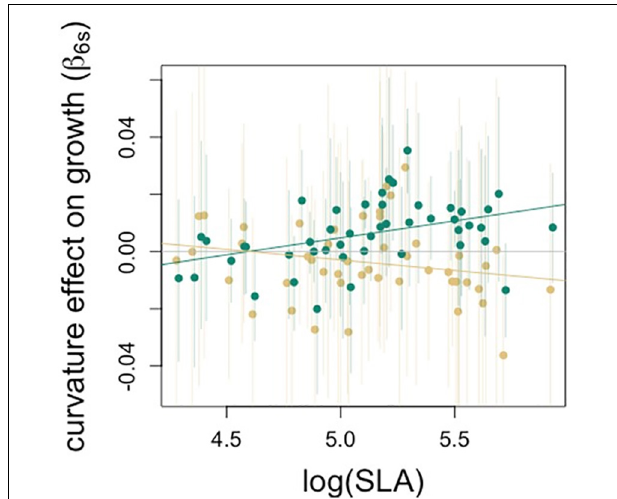
FIGURE 5 | Relationship between SLA and species-specific estimates of curvature effect on growth. The effect of SLA on the curvature-drought interaction term means that the extent to which the effect of curvature differs in drought years depends on species’ SLA. Green points show curvature effect on performance for average rainfall conditions during the non-drought years (2013, 2014, 2016), beige shows effects during the drought year.